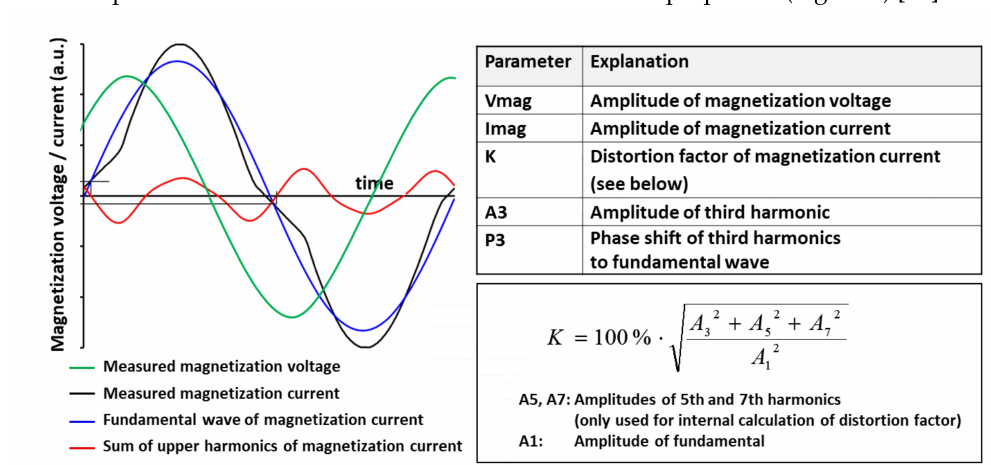
Figure 4. Schematic illustration of the harmonic analysis in the time domain signal of the magnetiza- tion current.